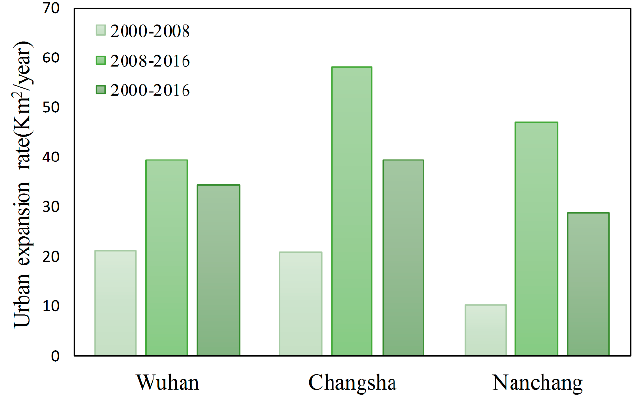
Figure 9. Urban expansion rate of the three cities from 2000 to 2016.